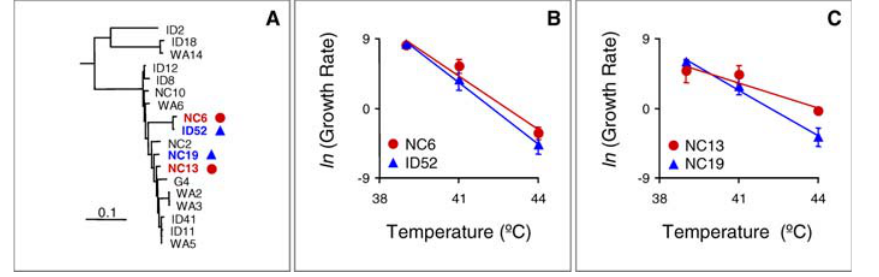
Figure 5. Growth Rates of Phage Isolated from Nature at High Temperatures (A) Phylogenetic relationships of G4-like phages recently isolated from environmental samples, modified from [24]. The genotypes of two pairs of sister taxa that differ at a locus (gene H: A47V) determined to have a large effect on reaction norm shape are indicated with blue (alanine) and red (valine). (B and C) Thermal reaction norms of the two phage pairs. Data are means 6 s.e.m. determined from four or five replicate measures at each temperature. DOI: 10.1371/journal.pbio.0040201.g005